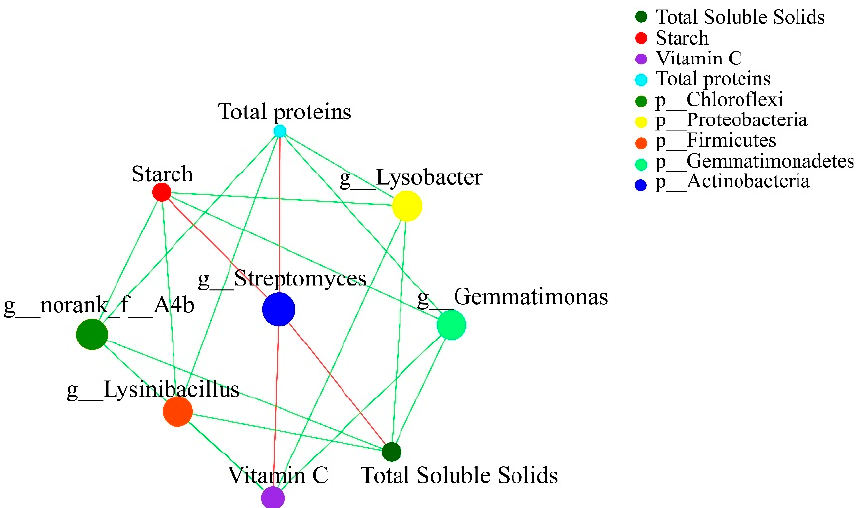
Figure 6. Correlation network analysis of quality characteristics of different pumpkin cultivars and soil bacteria at the genus level (top 50).